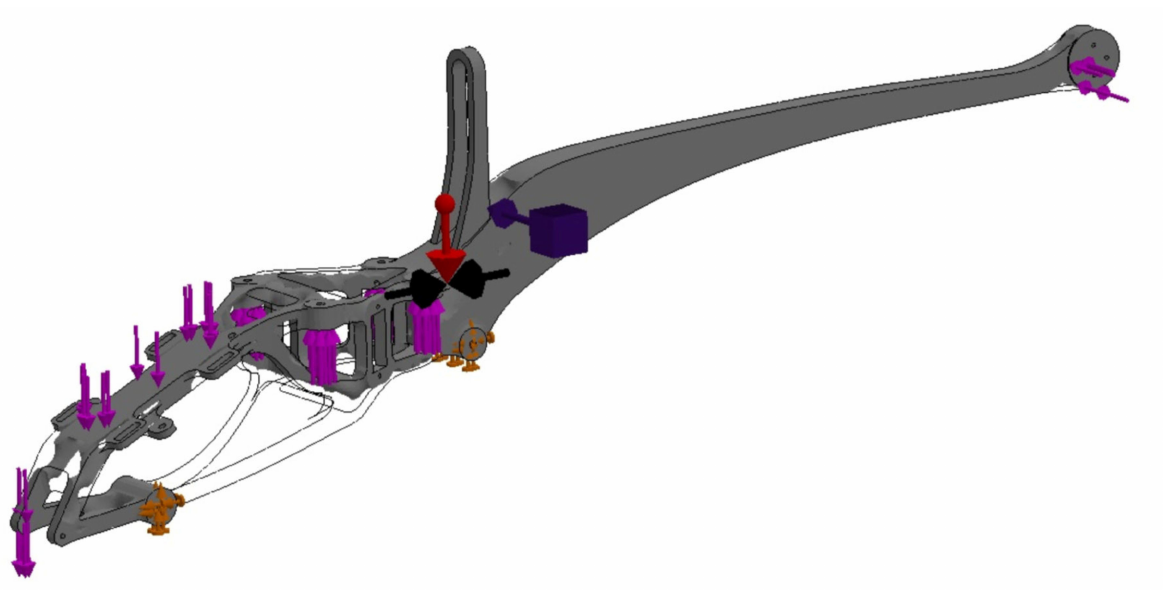
Figure 19. Model of the drone frame with applied boundary conditions and load, prepared based on the results of topological optimization.